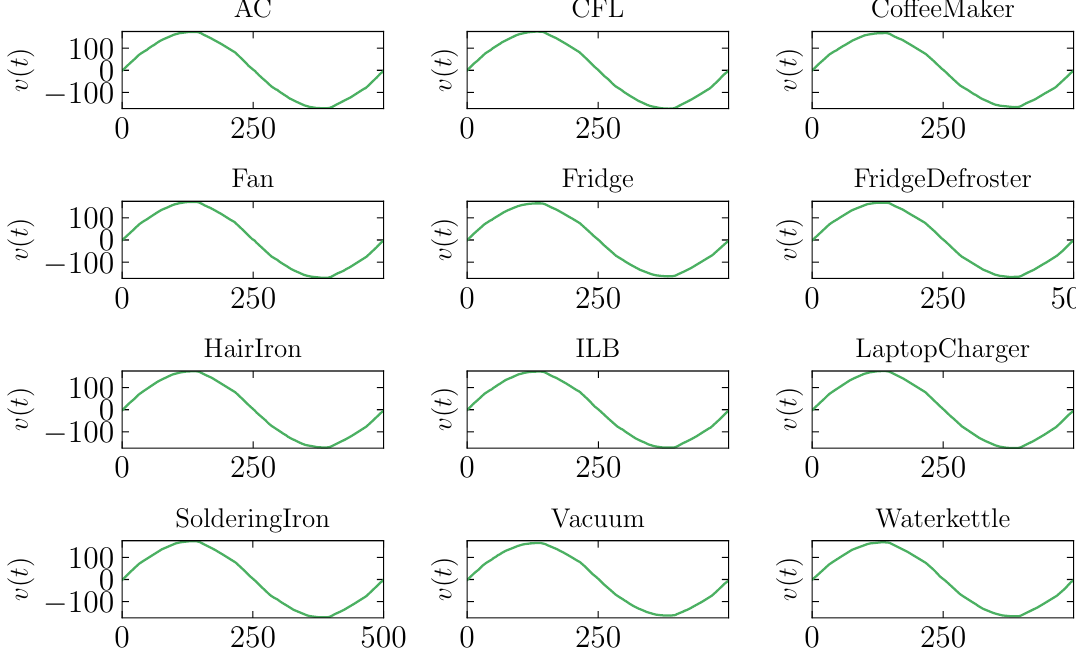
Figure 3. Activation voltage v ( t ) for different appliances in the PLAID dataset. The voltage has an almost identical pattern for all the